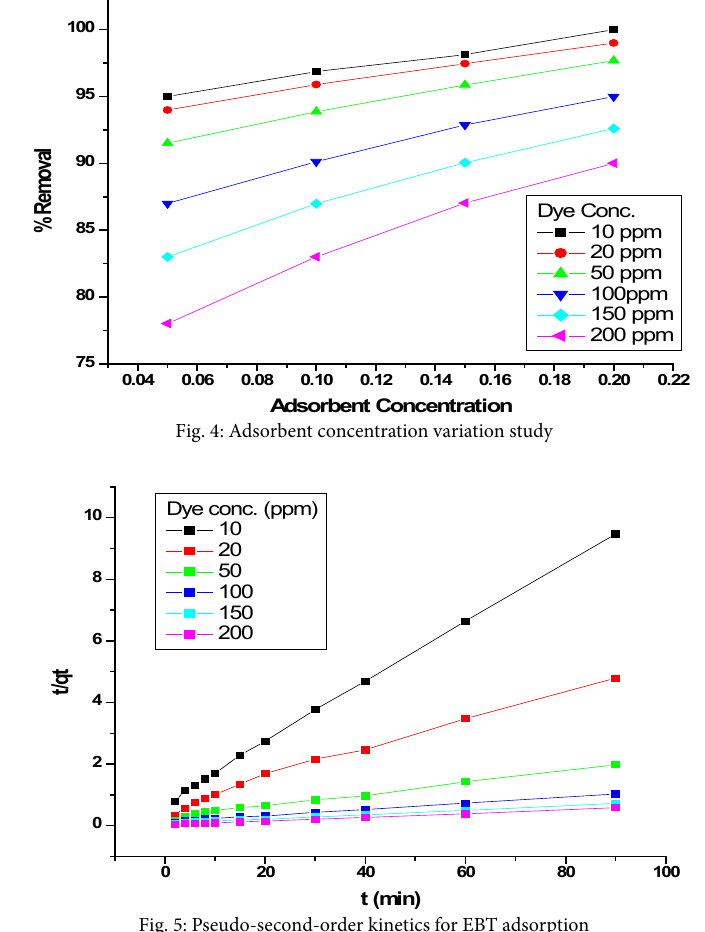
Fig. 5: Pseudo-second-order kinetics for EBT adsorption